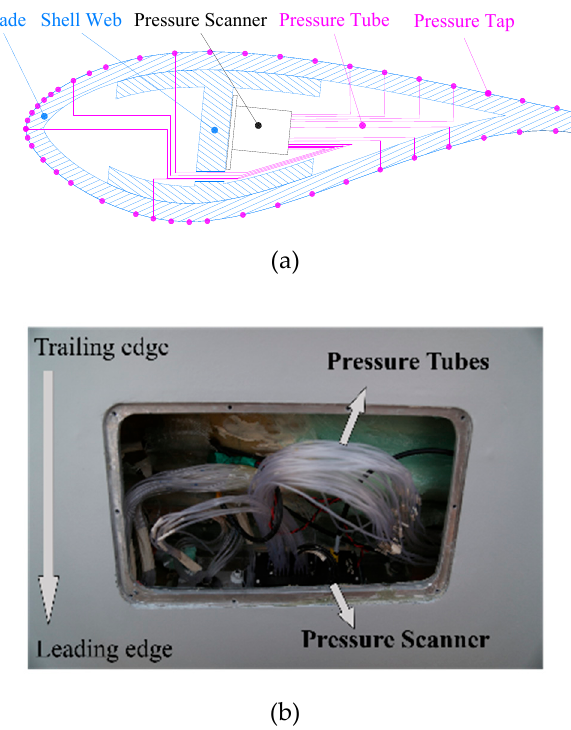
Figure 5. ( a ) Sketch diagram, and ( b ) photo of surface pressure measurement system on blades.